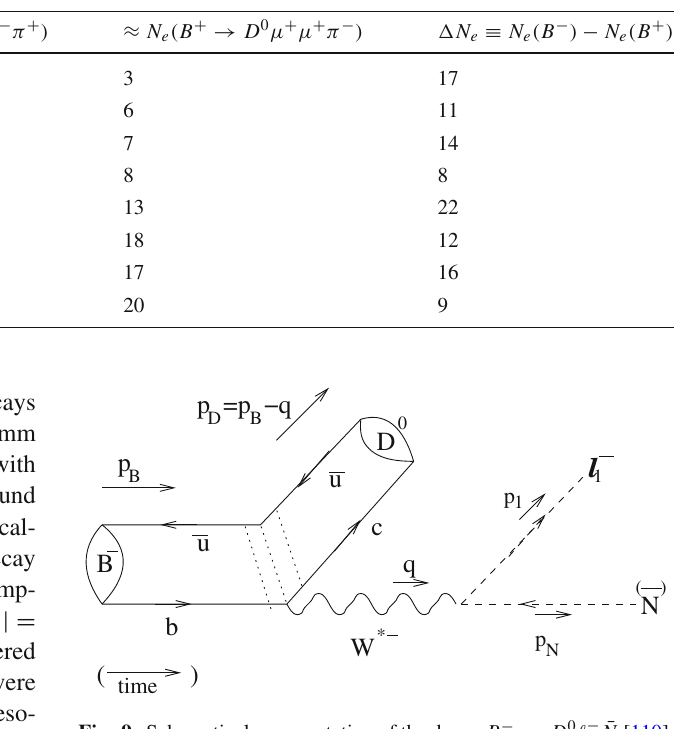
Fig. 9 Schematical representation of the decay B − → D 0 (cid:2) −